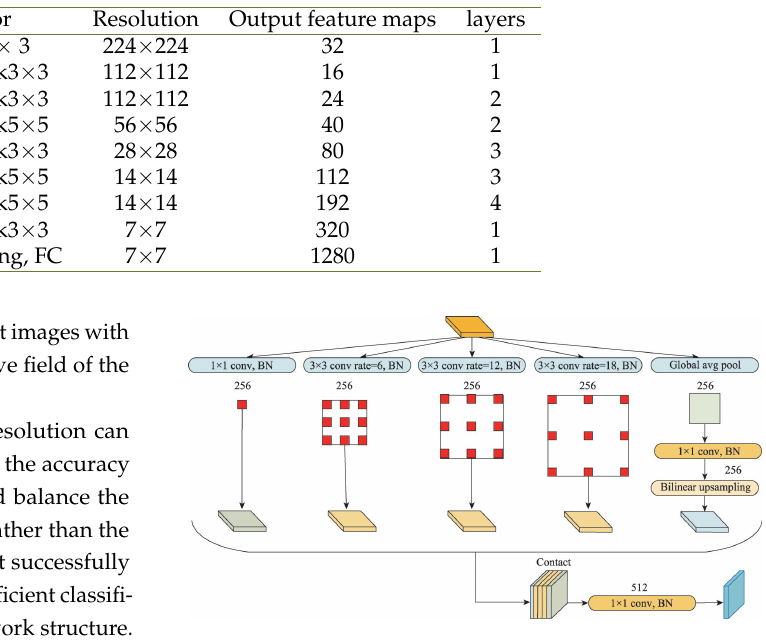
Table 1. EfficientNet-B0 network